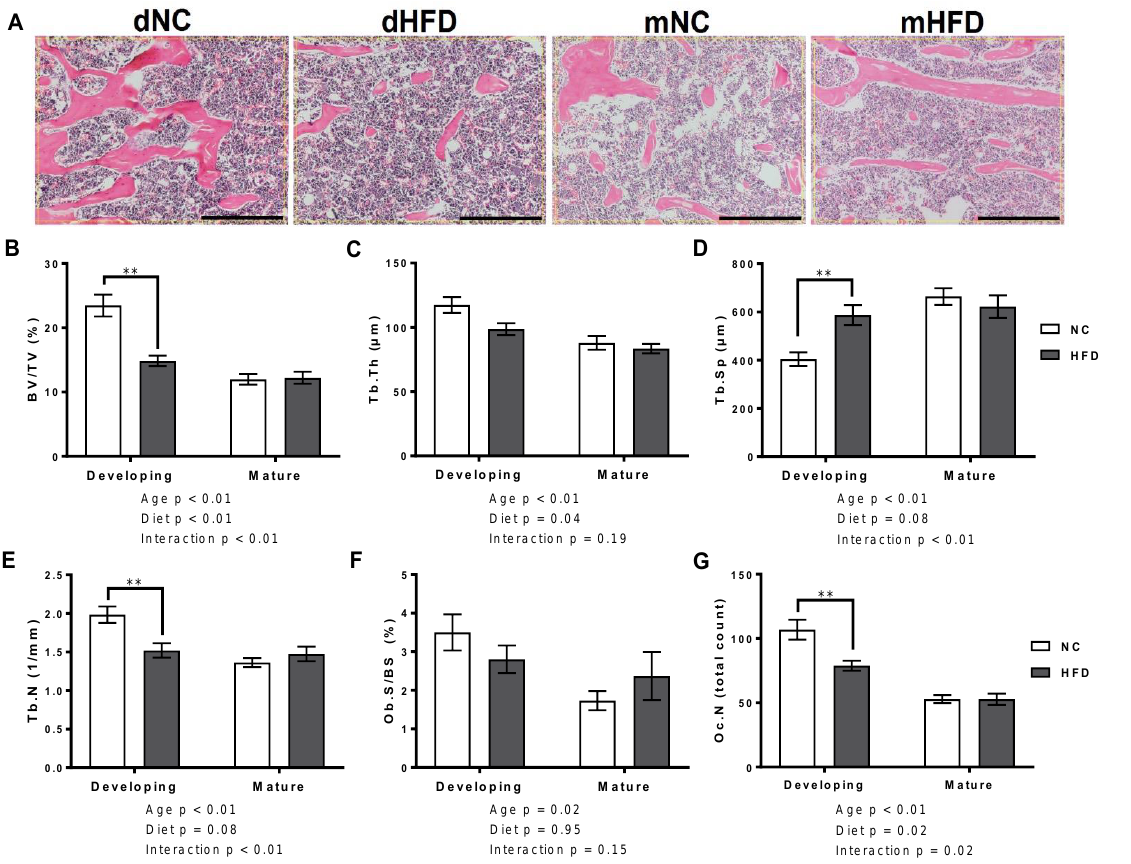
Figure 5. The high fat diet adversely affected structural and cellular histomorphometric outcomes in developing mice but had no effect in mature mice. ( A ) Ex vivo 2D histomorphometry regions of interest at 20x magnification analysed for developing normal chow (dNC), developing high fat diet (dHFD), mature normal chow (mNC) and mature high fat diet (mHFD) groups. Scale bar represents 1 mm. ( B – G ) Bone volume to total volume ratio (BV/TV), trabecular thickness (Tb.Th), trabecular spacing (Tb.Sp), trabecular number (Tb.N), osteoblast surface to bone surface ration (Ob.S/BS) and osteocyte count (Oc.N) of developing and mature mice on normal chow (NC) and high fat diets (HFD). Results are presented as mean ± SEM ( n = 7 per group), ** represents p < 0.01, (2-way ANOVA followed by Bonferroni post-hoc analysis comparing diet within age groups).